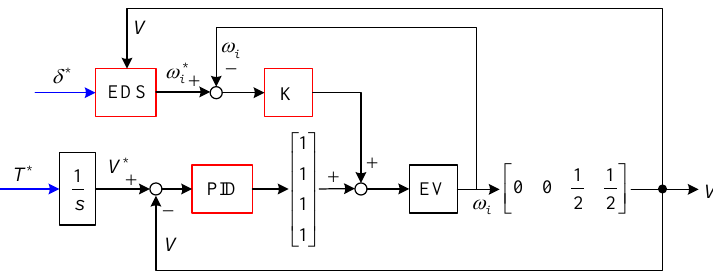
Figure 4. Control block diagram of the proposed system.